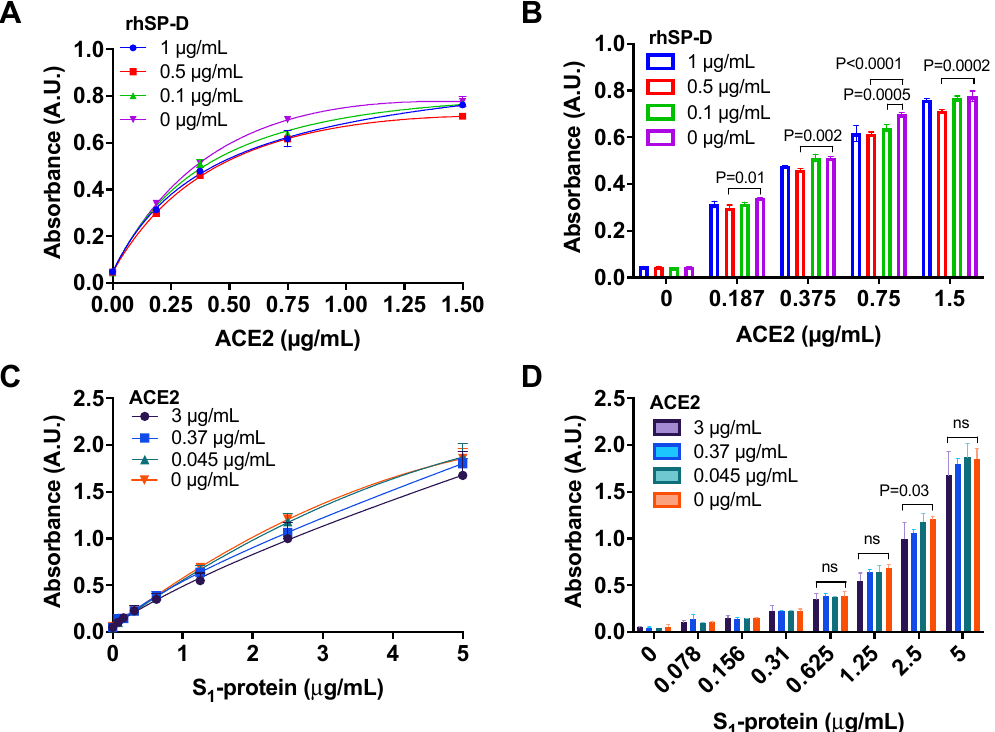
Figure 3. ACE2 does not interfere in the binding of rhSP-D to the spike-(S)-protein of SARS-CoV-2. ( A , B ) An ELISA assay was performed to determine if rhSP-D could decrease the binding of ACE2 to S 1 -protein (Wuhan variant). Binding of ACE2 to S 1 -protein immobilized on the wells was determined in the presence of different concentrations of rhSP-D 1 µ g/mL (blue, circles), 0.5 µ g/mL (red, squares) or 0.1 µ g/mL (green, upward triangles) and 0 µ g/mL (pink, downward triangles) (positive control for the binding of ACE2 to S 1 -protein). rhSP-D promoted a slight decrease in the interaction between S 1 -protein and ACE2. The reduction induced by rhSP-D at 0.5 µ g/mL was significant compared to the positive control (no rhSP-D: 0 µ g/mL). ( C , D ) Binding of S 1 -protein to rhSP-D (immobilized on the wells) in the presence of different concentrations of ACE2: 3 µ